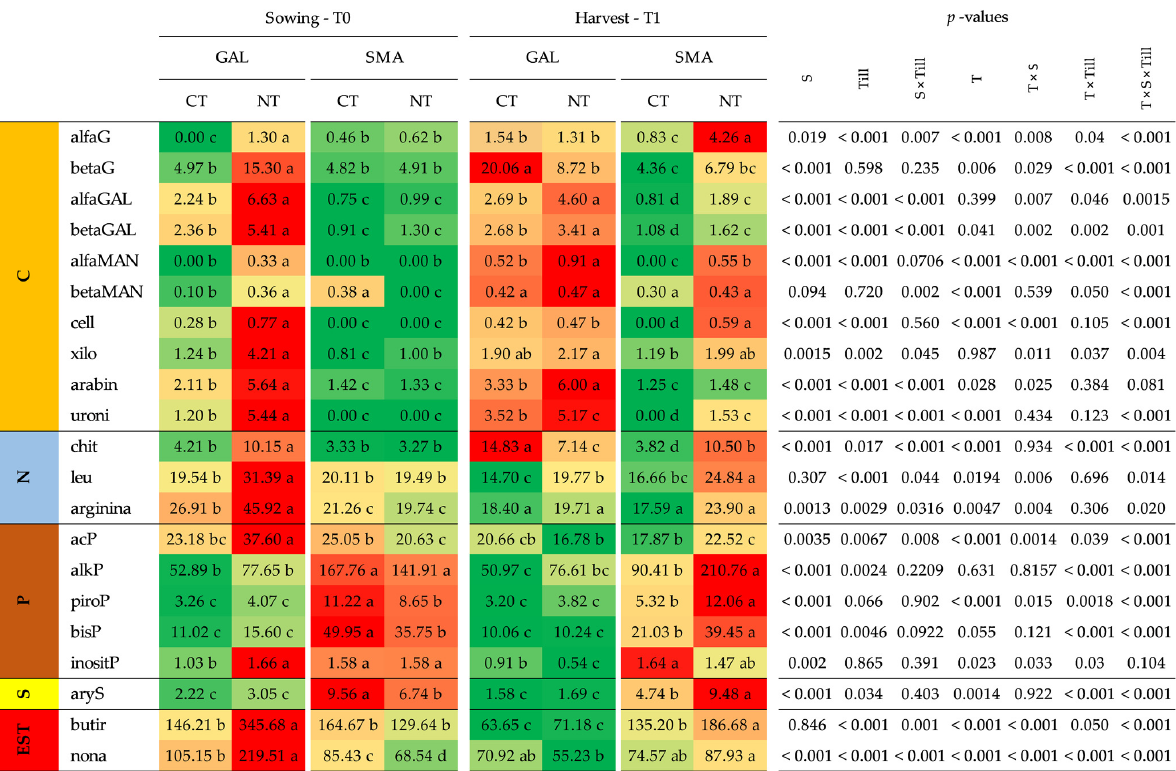
Figure 6. Effect of soil (GAL and SMA), tillage system (CT and NT), sampling time (sowing—T0 and harvest—T1), and their interaction on soil enzymes: α -glucosidase (alfaG), β -glucosidase (betaG), α -galactosidase (alfaGAL), β -galactosidase (betaGAL), α -mannosidase (alfaMAN), β -mannosidase (betaMAN), β -1,4-glucanase (cell), β -1,4-xylanase (xilo), α -arabinase (arabin), β -D-glucuronidase (uroni) involved in C cycling; N-acetyl-b-D-glucosaminidase (chit), leucine amino-peptidase (leu), trypsin-like protease (arginina) involved in N cycling; acid (acP) and alkaline phosphomonoesterase (alkP), pyrophosphodiesterase (piroP), phosphodiesterase (bisP), inositol-P phosphatase (inositP) involved in P cycling; (iv) arylsulfatase (aryS) involved in S cycling and (v) butirate (butir) and nonanoate (nona) esterase. Reported values are means ( n = 4). Cell colours vary from green (low concentration) to red (high concentration). Different letters indicate significant differences within each sampling time (Tukey’s HSD test at p < 0.05) between treatments (Soil × Tillage).